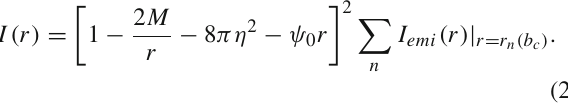
The function r n ( b c ) is the radial location at which the light rays intersect with the disk. It is referred as the transfer func- tion, where n = 1 , 2 , 3 . . . . At each point of b c , there will produce a slope of the transfer function dr / db c , which rep- resents the demagnification factor. Note that, the absorption of brightness which may abate the observation intensity has been neglected here. In Fig. 4, we have plotted the first three transfer functions r n ( b ) with respect to the impact parameter b c for the f ( R ) global monopole black hole. In Fig. 4, the red, blue and green lines correspond to the first( n = 1), second( n = 2) and third( n = 3) transfer func- tion, respectively. The slope of those lines are very different. For the red line, the value of its slope is in the neighbour- hood of 1. So, this line is related to the direct image of the disk, which represents the redshifted source profile. While, the blue line’s slope increase quickly and is much